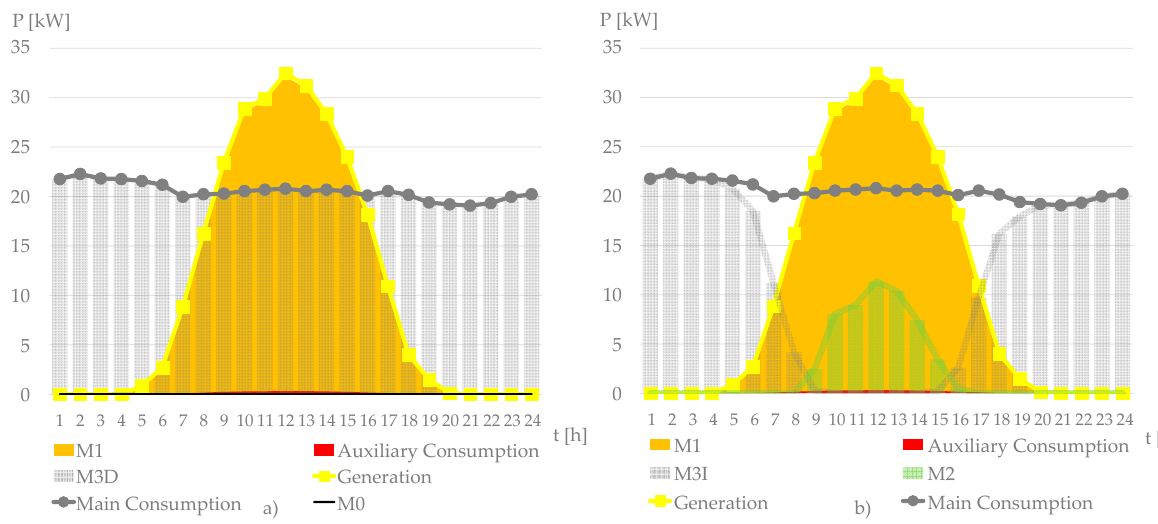
Figure 4. Hourly generation, consumption and energy registered by the M0, M1, M2, M3 metering points for a representative non-working day of July for the case study facility arranged as: ( a ) direct-connected; ( b ) installation-connected. Self-elaboration. In both subplots it is represented the generated power profile in yellow colour with square markers, the main consumption power profile in grey colour with round markers and a negligible auxiliary consumption in red colour. The area under the generated